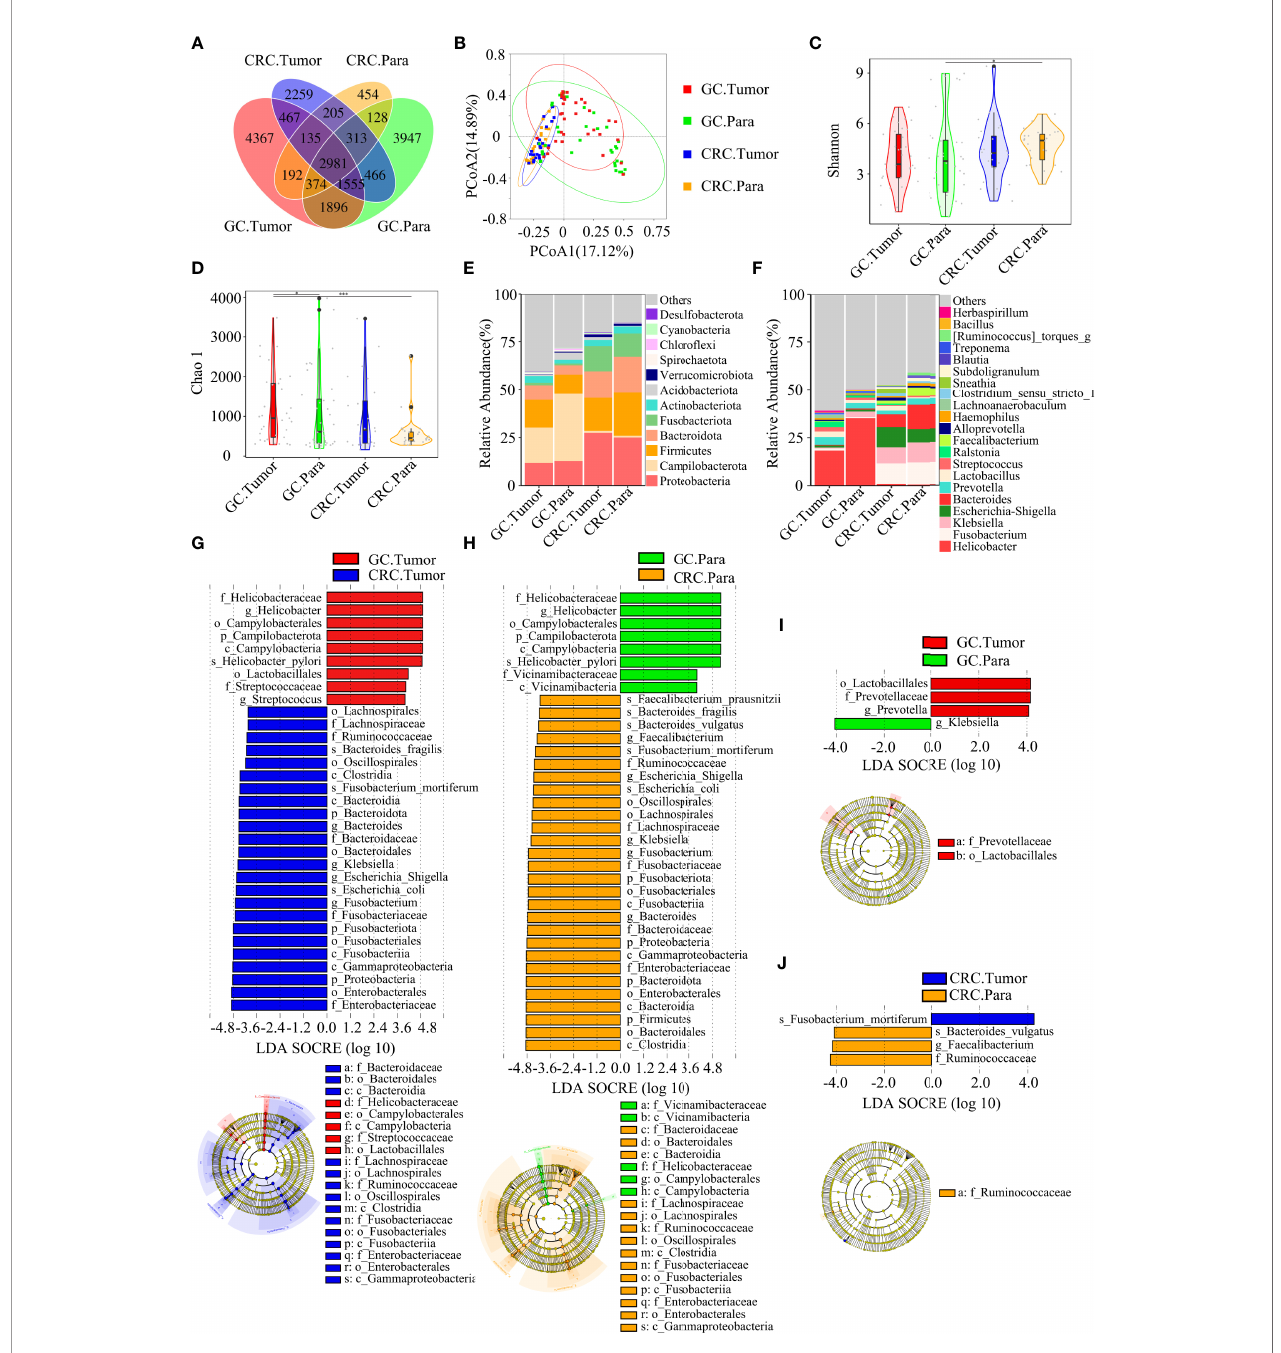
FIGURE 5 | There were many similarities and differences in the microbial diversity of tissue between GC and CRC. GC.Tumor ( n = 33), GC.Para ( n = 36), CRC.Tumor ( n = 24), and CRC.Para ( n = 24). (A) The Venn diagram displayed the overlaps among groups, showing a total of 19,739 OTUs. (B) PCoA calculated b - diversity on a distance (dissimilarity) matrix of Bray – Curtis indexes. The Shannon index (C) and Chao1 index (D) were used to evaluate the microbial diversity of tissues in patients with GC and CRC. Composition of tissue microbiota at the phylum level (E) and genus level (F) among the four groups. LDA and LEfSe methods were used to analyze the speci fi c characterization of the tissue microbiota of patients with GC and CRC. (G) The LEfSe method identi fi ed the most divergent taxa in GC and CRC and scored both groups of tumor samples by LDA. (H) The LEfSe method identi fi ed the most divergent taxa in GC and CRC, and scored both groups of paracancerous samples by LDA. (I) The LEfSe method identi fi ed the most divergent taxa in tumor and paracancerous tissues of GC and scored both groups of samples by LDA. (J) The LEfSe method identi fi ed the most divergent taxa in tumor and paracancerous tissues of CRC and scored both groups of samples by LDA. Only the taxa that reach the effective threshold of LDA >4 were displayed. The brightness of each point was proportional to the size of its effect. Para, paracancerous tissues. * p < 0.05, *** p <